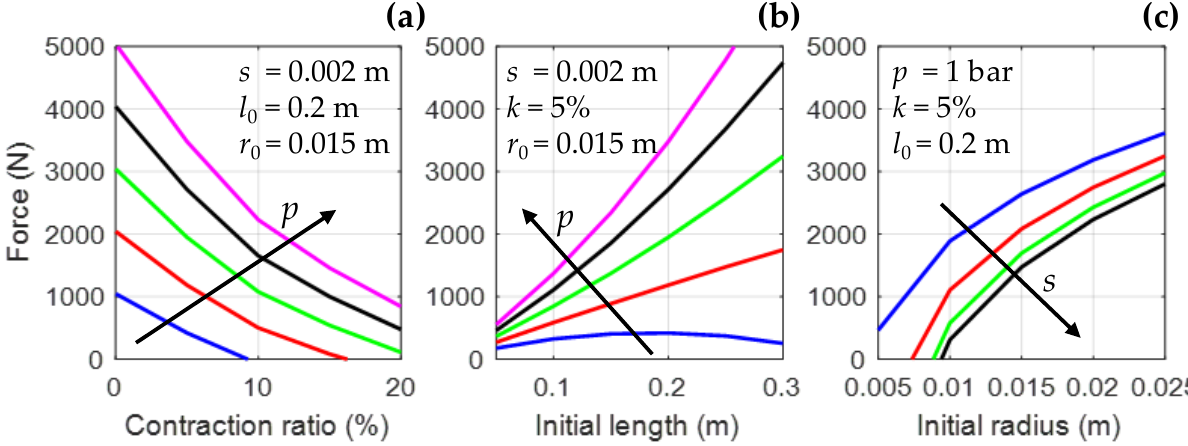
Figure 5. Traction force of straight fiber muscle for different physical and functional parameters. ( a ) The SFM tensile force for different contraction ratio ( k ) and supply pressure p [0.5; 0.75; 1; 1.25; 1.5] bar; ( b ) The SFM tensile force for different initial length l 0 and p ; ( c ) The SFM tensile force for differ- ent initial radius r 0 and thickness s of the inflatable chamber [1; 2; 3; 4] mm.